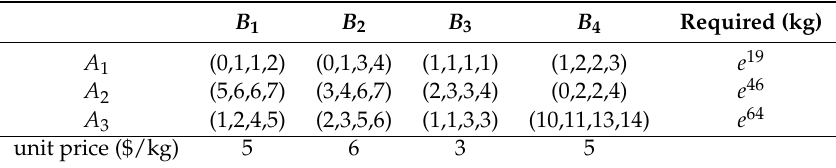
Table 1. The percentage of concrete and its unit